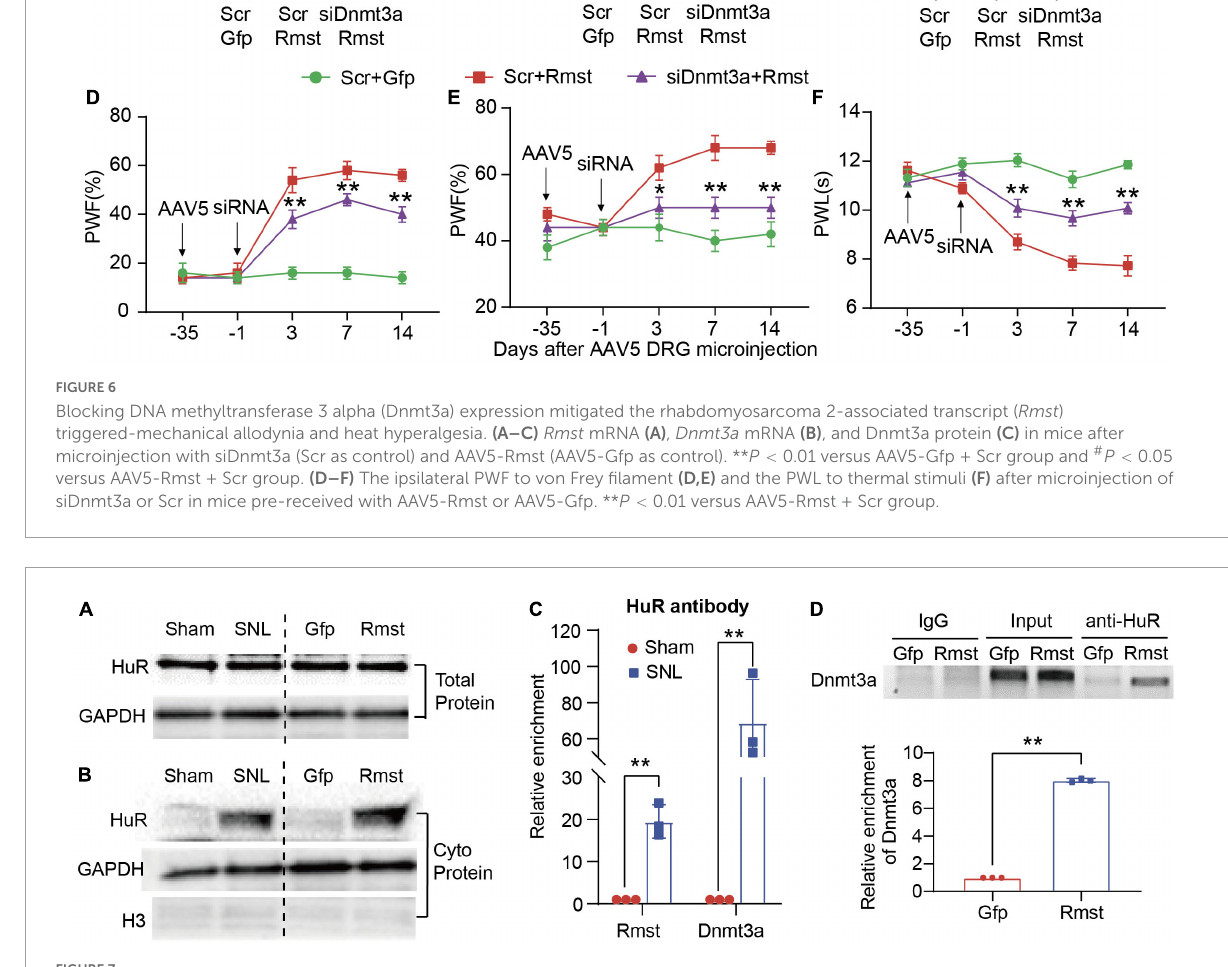
FIGURE7 Rhabdomyosarcoma 2-associated transcript ( Rmst ) was interaction with HuR to regulate the Dnmt3a mRNA Stability Under NP Condition. (A,B) Level of HuR expression in total protein (A) and cytoplasm protein (B) in DRG with SNL model and AAV5-Rmst (AAV5-Gfp as control) DRG microinjection. (C) Level of Rmst or Dnmt3a mRNA immunoprecipitated by anti-HuR on day 7 post-SNL surgery n = 3 biological repeats. ** P < 0.01 versus sham group. (D) Level of Dnmt3a immunoprecipitated by HuR in DRG neuron with AAV5-Rmst. n = 3 biological repeats. ** P < 0.01 compared with AAV5-Gfp